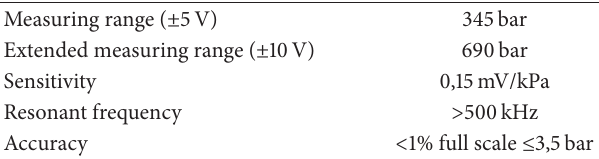
Table 4: Piezotronics PCB 102B pressure sensor technical data